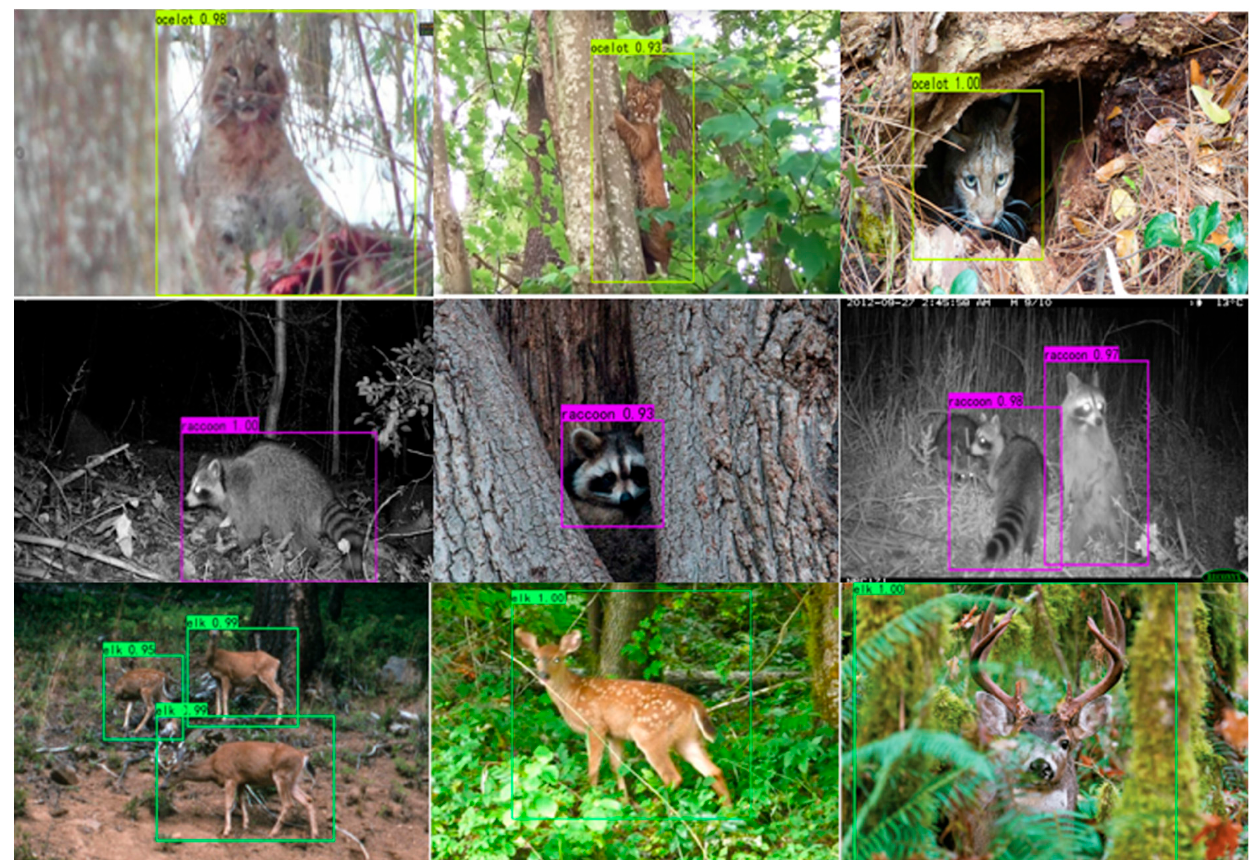
Figure 8. Detection results and confidence in the real environment in the wild.